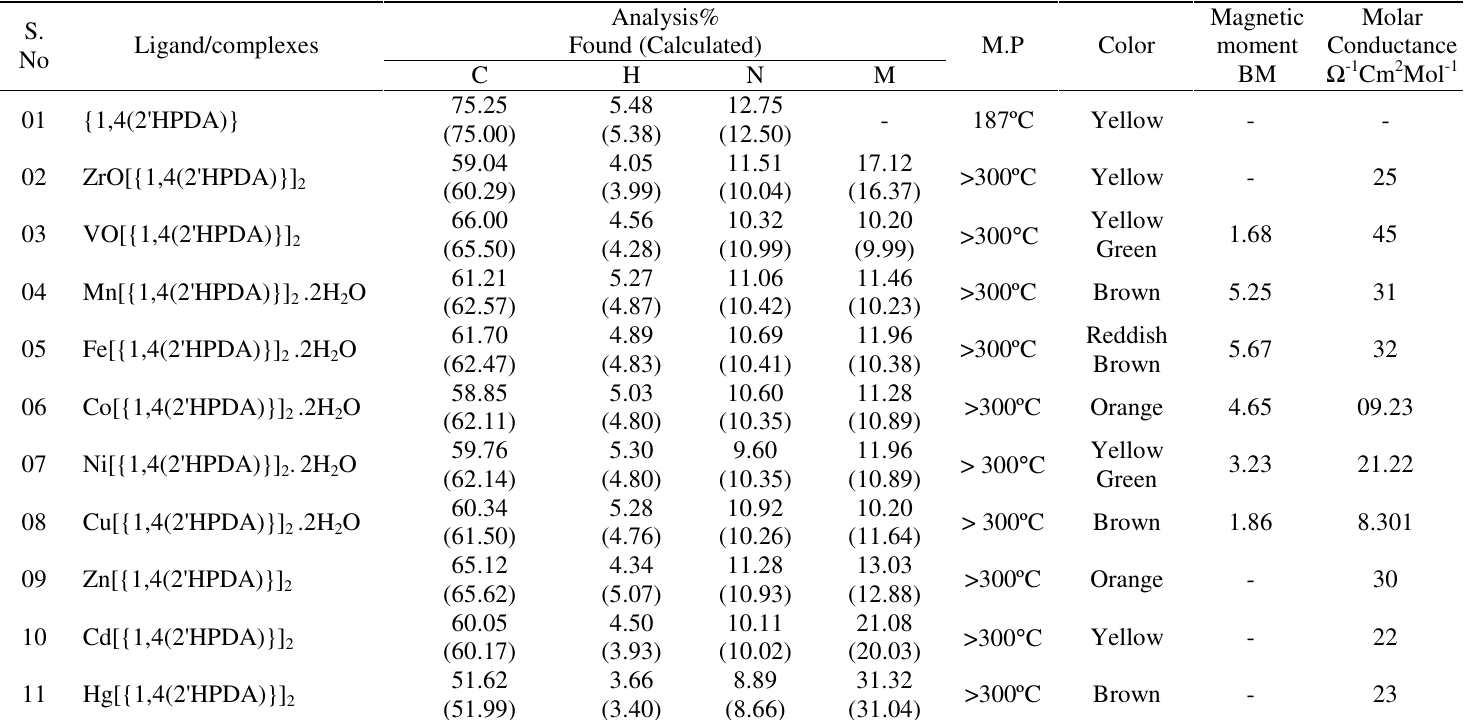
Table 1. Elemental analysis, Color, Melting point and Conductance data for {1,4(2'HPDA)} and Metal